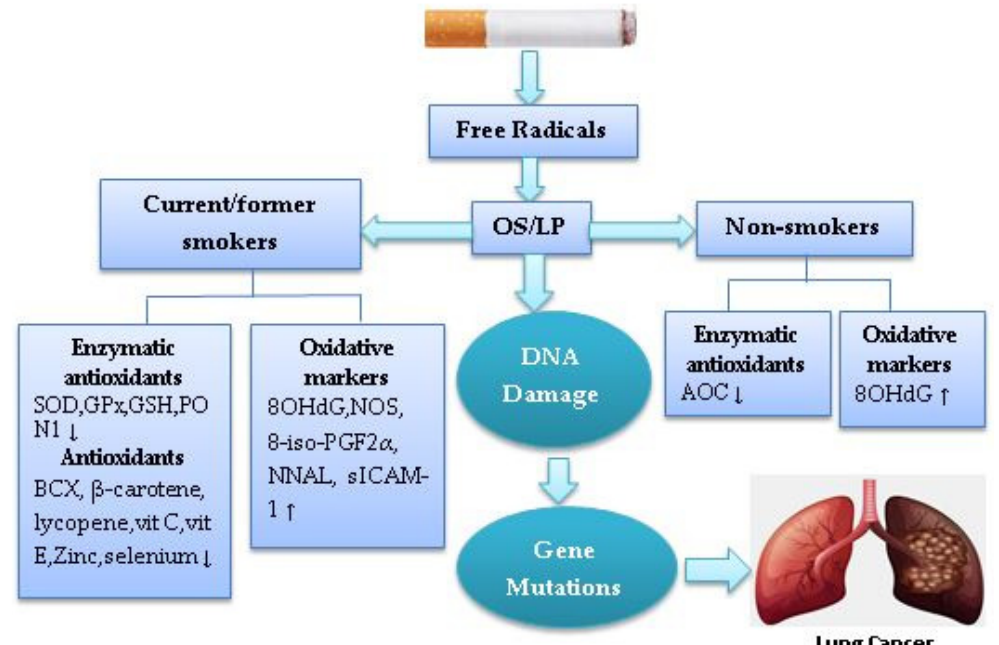
Figure 1. The schematic diagram of cigarette smoke-induced oxidative stress in lung cancer. ( ↓ ) decrease, ( ↑ )